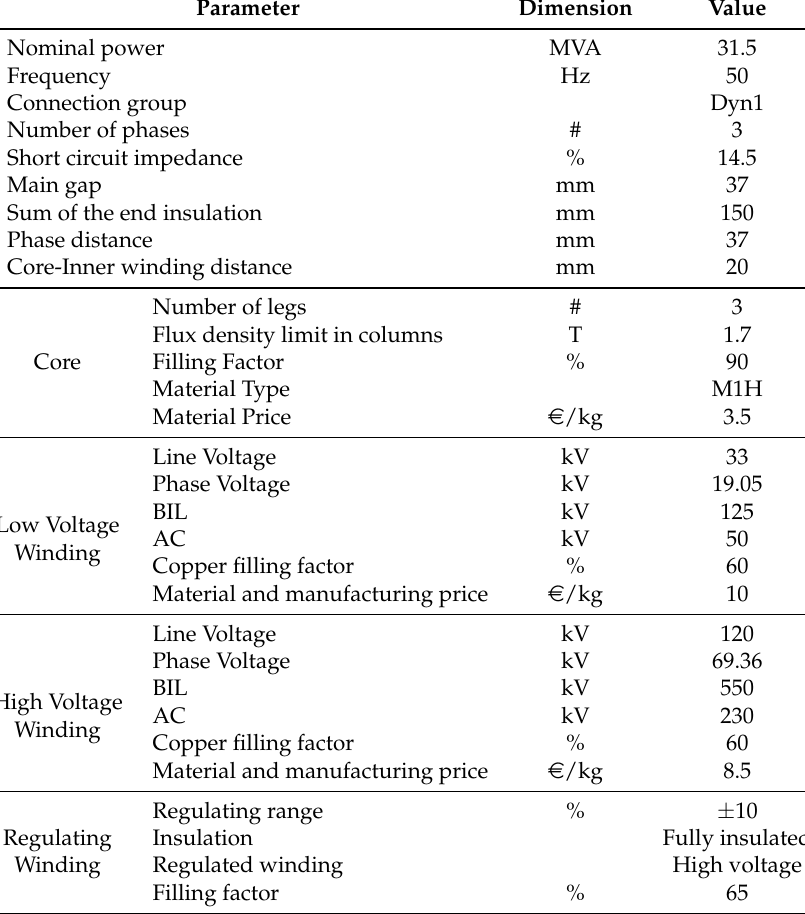
Table 3. List of the optimization model input parameters.